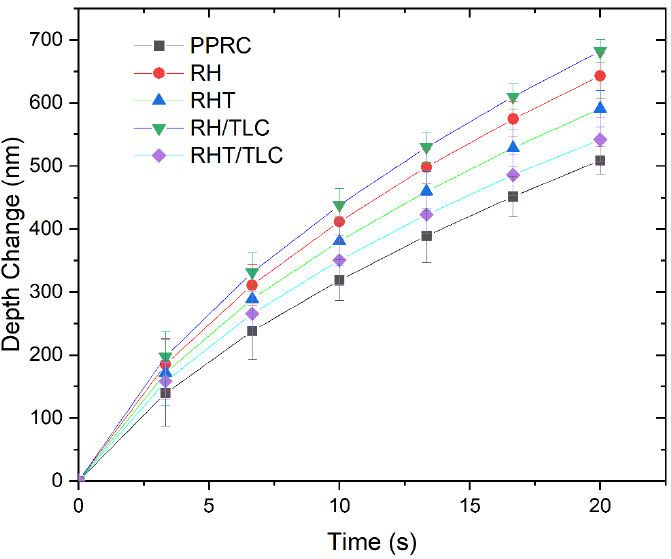
Figure 9. Depth change as a function of time for different samples.